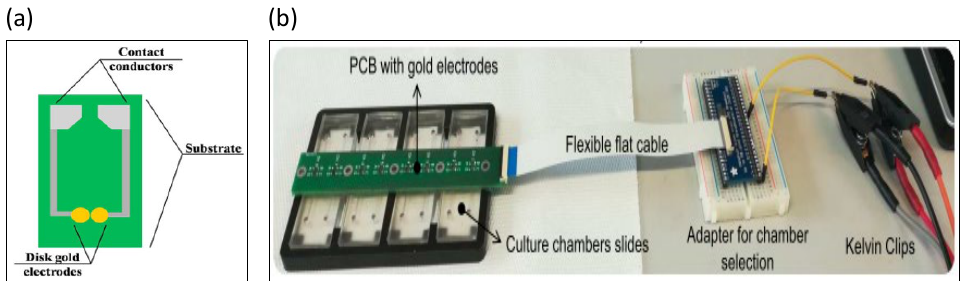
Figure 2. The PCB-based impedance biosensors. ( a ) Gold electrodes were printed on commercial printed circuit boards. Reproduced with permission from [35]. Copyright Scientific Reports 2013. ( b ) An electrical impedance sensor was used to detect the degree of fibrosis in liver tissue. Reproduced with permission from [37]. Copyright Biosensors 2022.